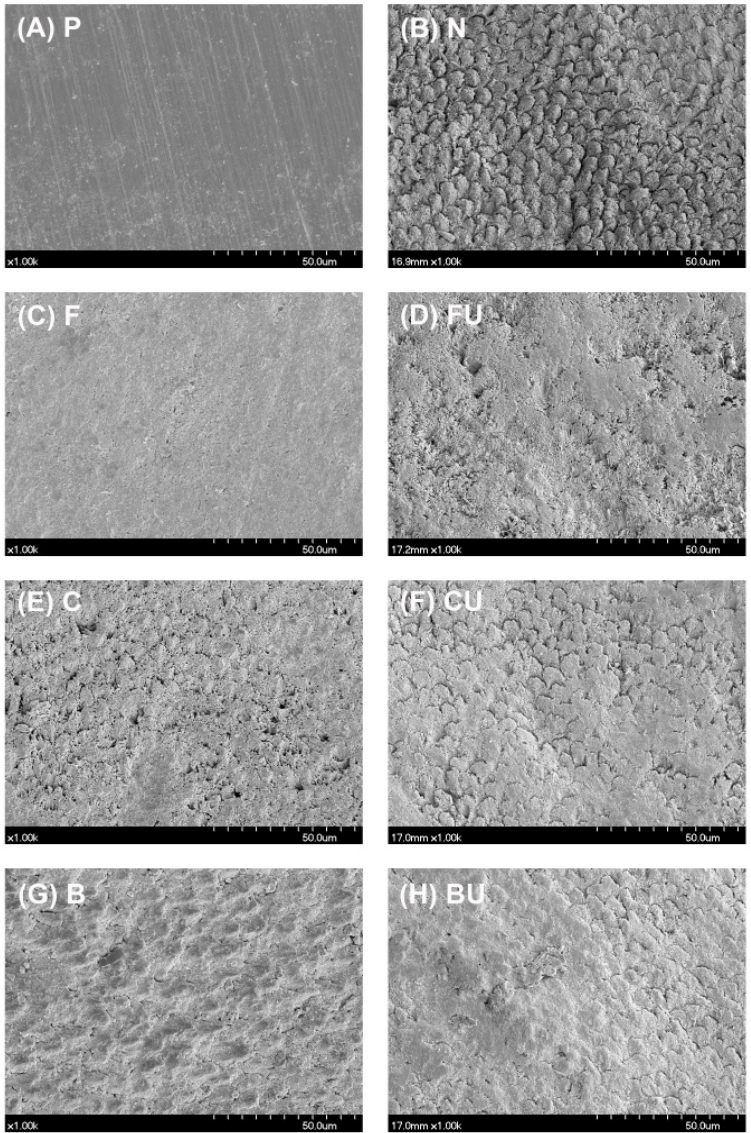
Figure 3. Representative FE-SEM images of all the experimental groups. ( A ) Group P, ( B ) Group N, ( C ) Group F, ( D ) Group FU, ( E ) Group C, ( F ) Group CU, ( G ) Group B, and ( H ) Group BU. Exposed enamel rods in Group N were covered with precipitates after the application of three varnishes with or without ultrasonication. An enamel surface covered with a smear layer was observed in Group P (Figure 3A).